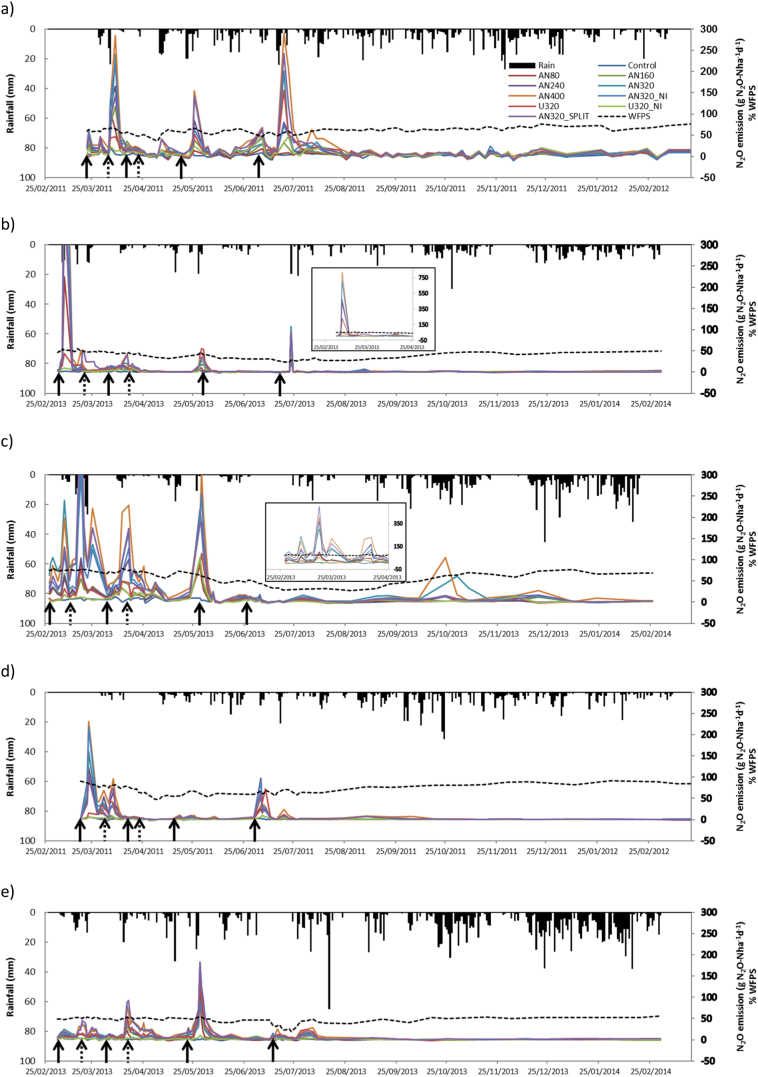
Evolution of daily N2O emissions, rainfall and WFPS at the measurement sites. a) Crichton, b) Drayton, c) North Wyke, d) Hillsborough, e) Pwllpeiran. Inserts in b) and c) show detail of the larger peaks. The continuous arrows correspond to fertiliser application; the dashed arrows correspond to the extra fertiliser additions in the split application treatments.